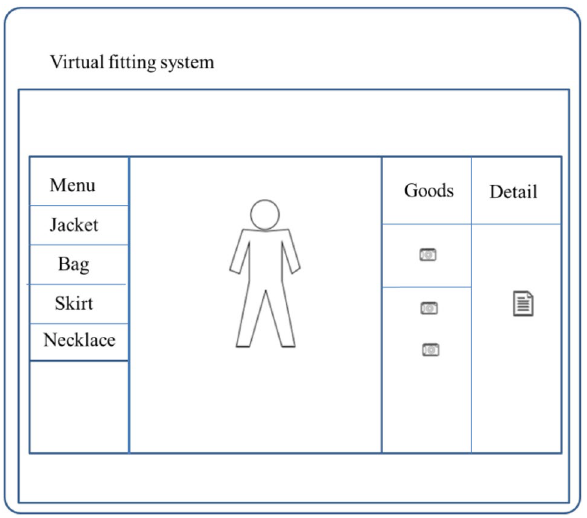
Figure 7. GUI interface layout